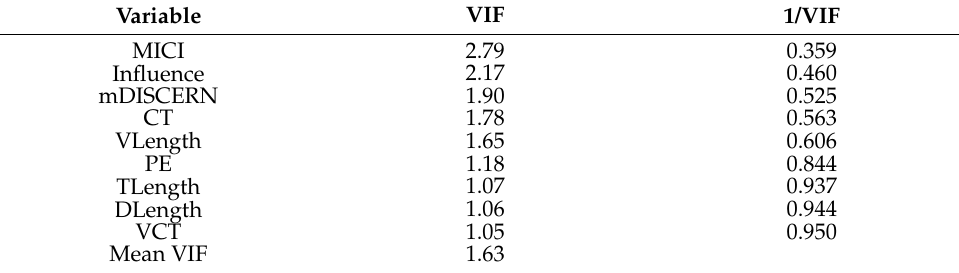
Table 9. Independent variable variance inflation